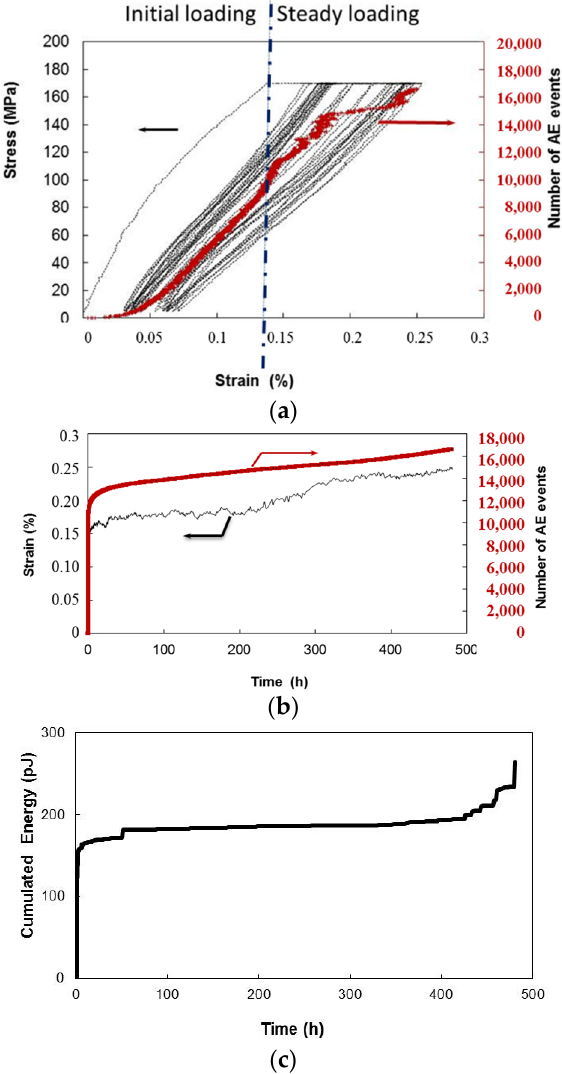
Figure 6. ( a ) Stress-strain curve and cumulated number of acoustic emission (AE) events recorded during initial loading up to the nominal load, and during the static loading at a constant load ( σ / σ R = 0.44 and T = 500 °C); ( b ) Strain and cumulated number of AE events versus time; ( c ) Cumulated acoustic energy versus time.